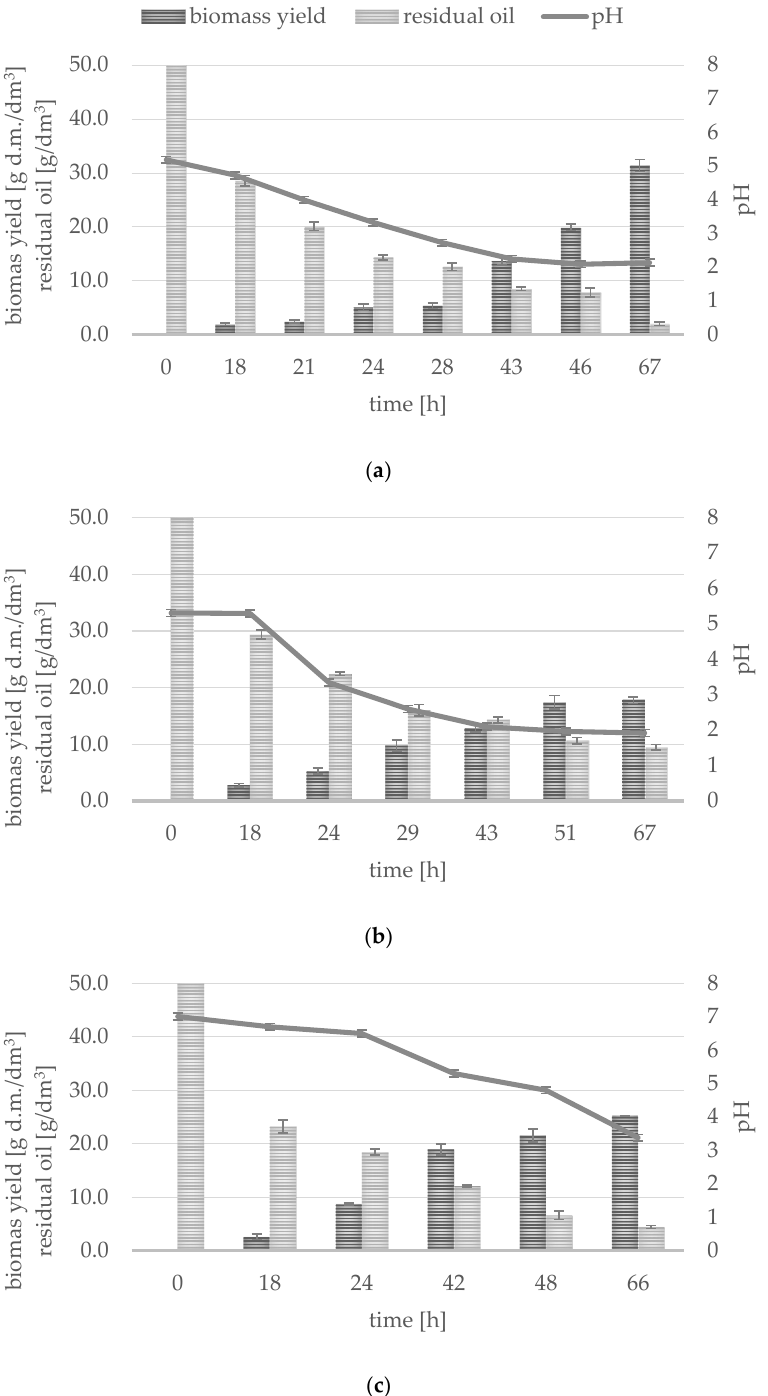
Figure 1. Changes in biomass yield, residual oil and medium pH during Y. lipolytica culture in media: ( a ) A -pfWO-N-0.25-Aer-reg, ( b ) B-pfWO-N-0.50-no-Aer-reg, ( c ) C-H-pfWO-N-0.25-no-Aer-reg (for abbreviation see Table 1).